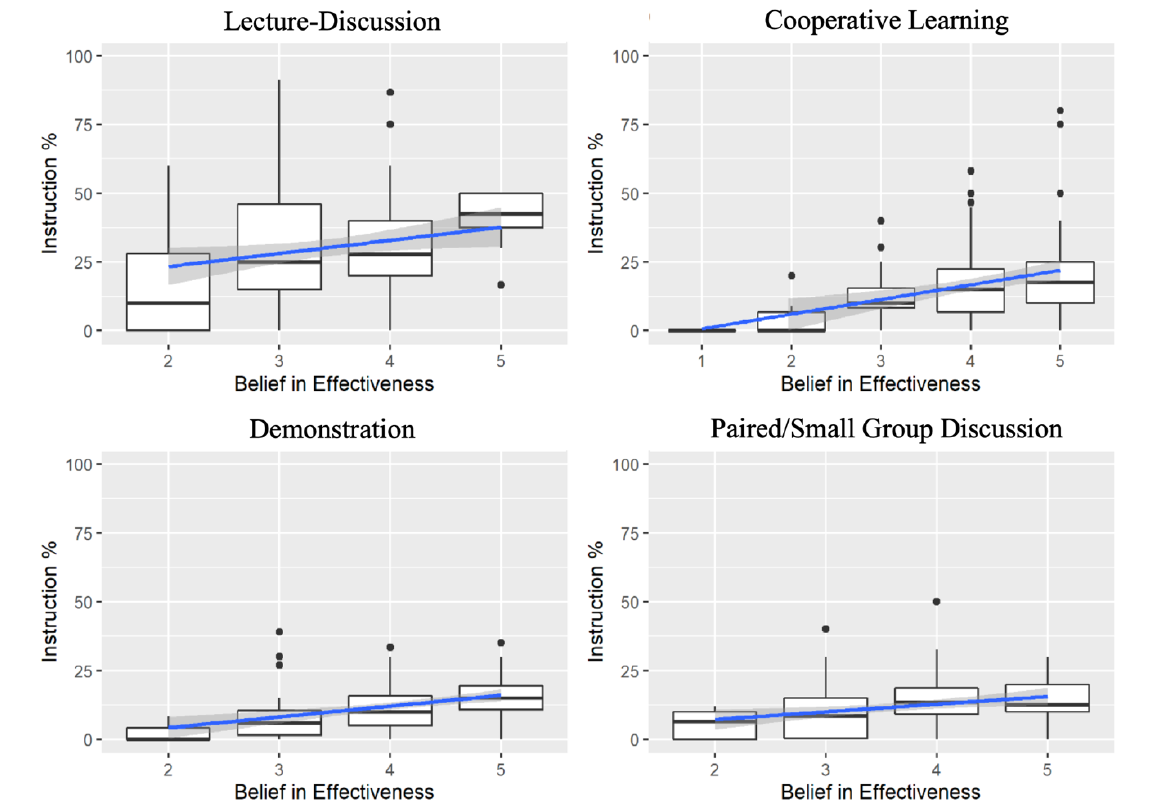
Boxplots Showing Percentage of Time Spent Teaching in Each Method Based on Teacher Belief in Said Method’s